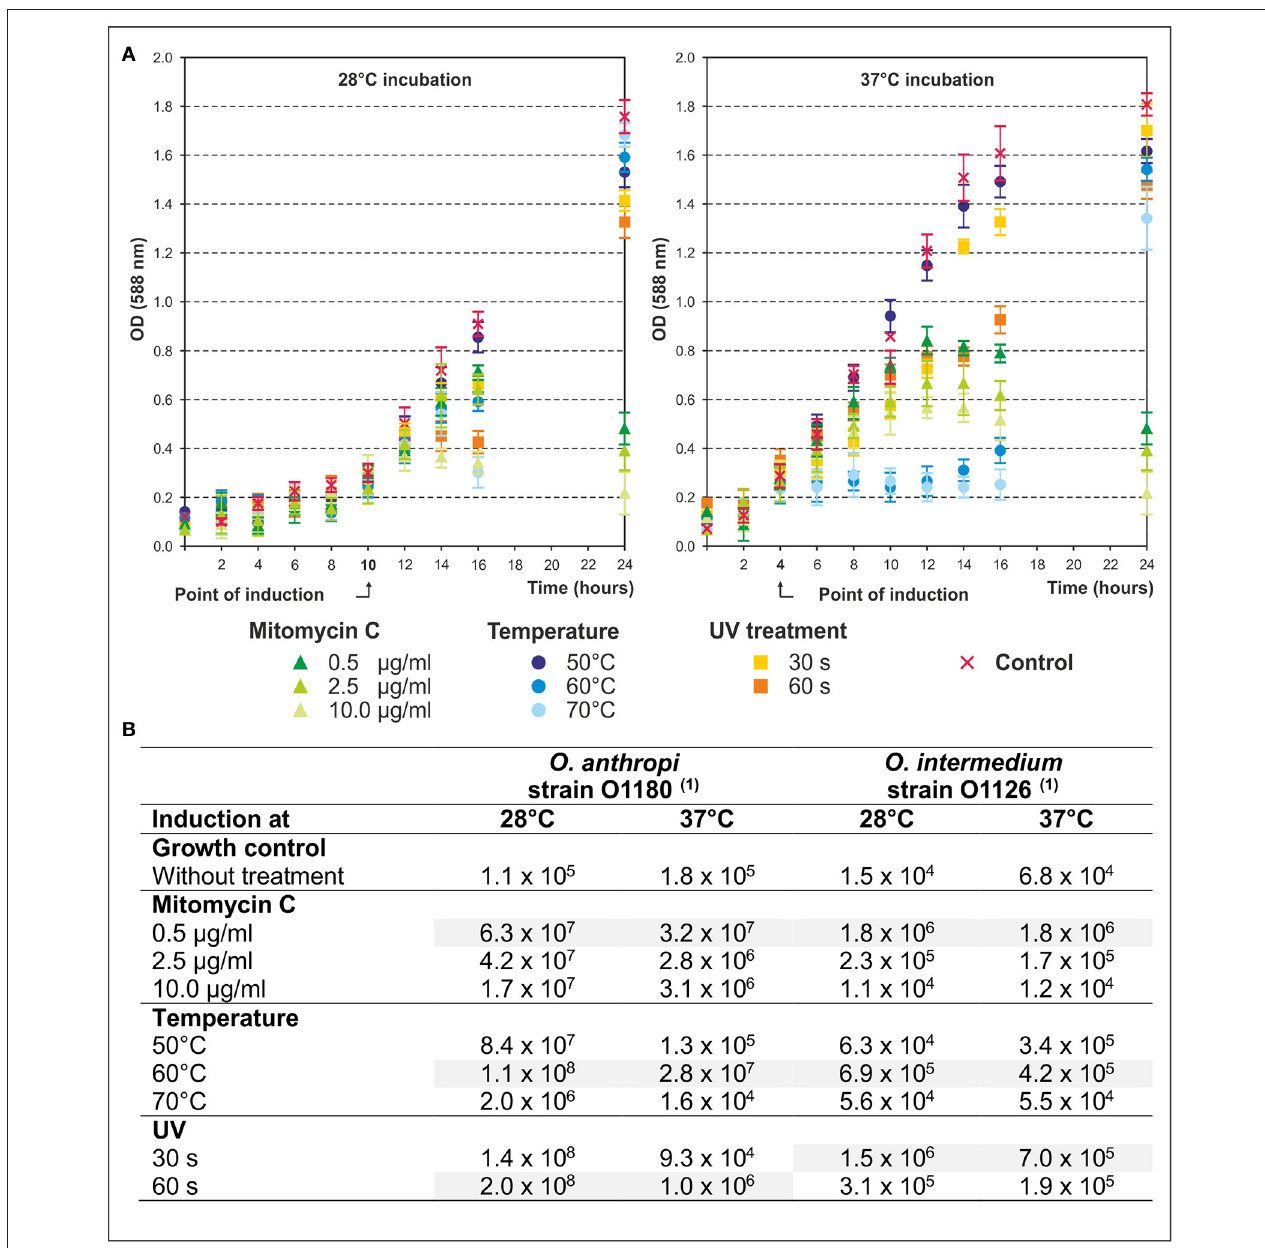
FIGURE 1 | Efficacy of phage release during mitomycin C, temperature, and UV treatment. (A) In the diagrams the bacterial growth of O. anthropi strain O1180 during stress treatment at 28 and 37 ◦ C is shown. Given are mean values of three independent experiments. Error bars indicate the standard deviation from the mean value. The point of induction (OD 588nm ) is indicated. (B) The table summarizes the results of the phage induction by different stress factors. The phage titer is given in pfu/ml. (1) Plaque formation was investigated on O. anthropi strain